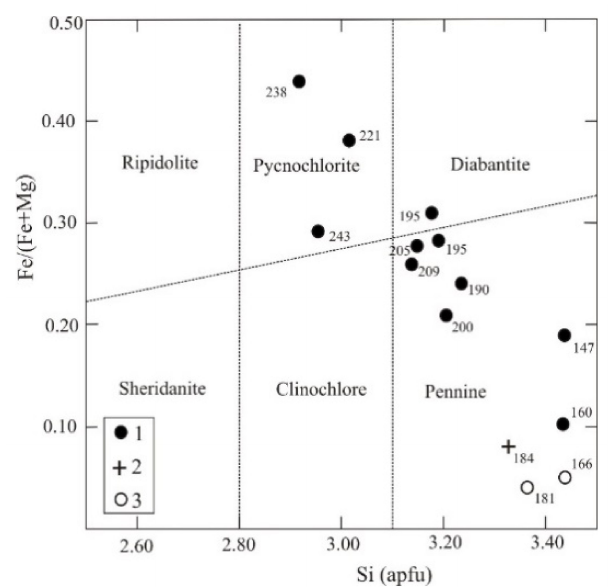
Figure 7. Chlorite composition on the classification diagram from [20]. Analyses of chlorite from clinopyroxenites I (1), II (2), and III (3). Numbers show the formation temperatures calculated with a chlorite geothermometer [19] (Table